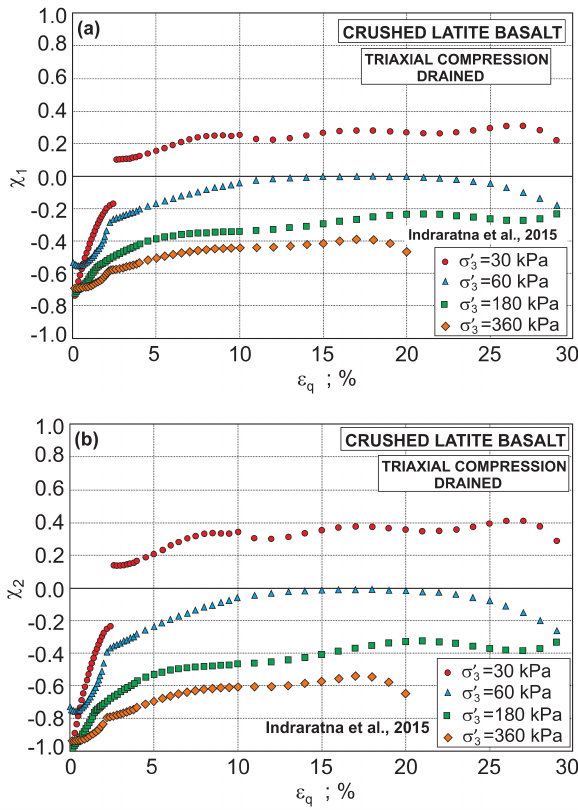
Figure 6: Relationships q εχ− : (a) q εχ − 1 ; (b) q εχ − 2